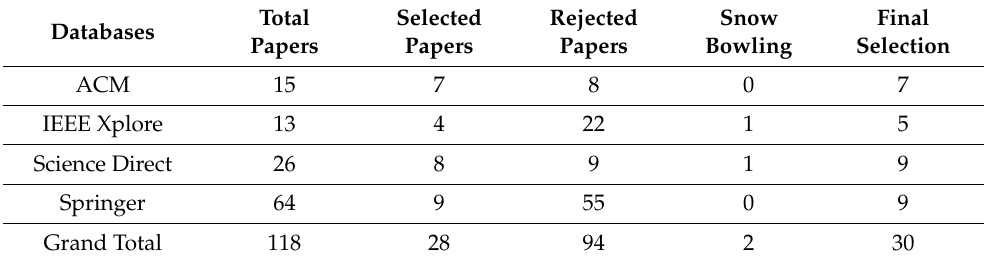
Table 2. Number of papers selected for SLR.